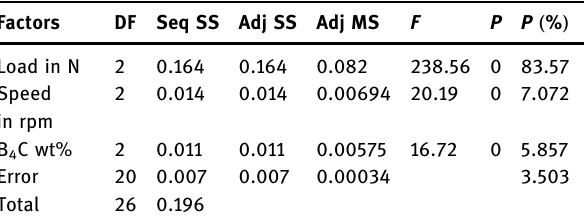
Table 6: Wear rate analysis using ANOVA Factors